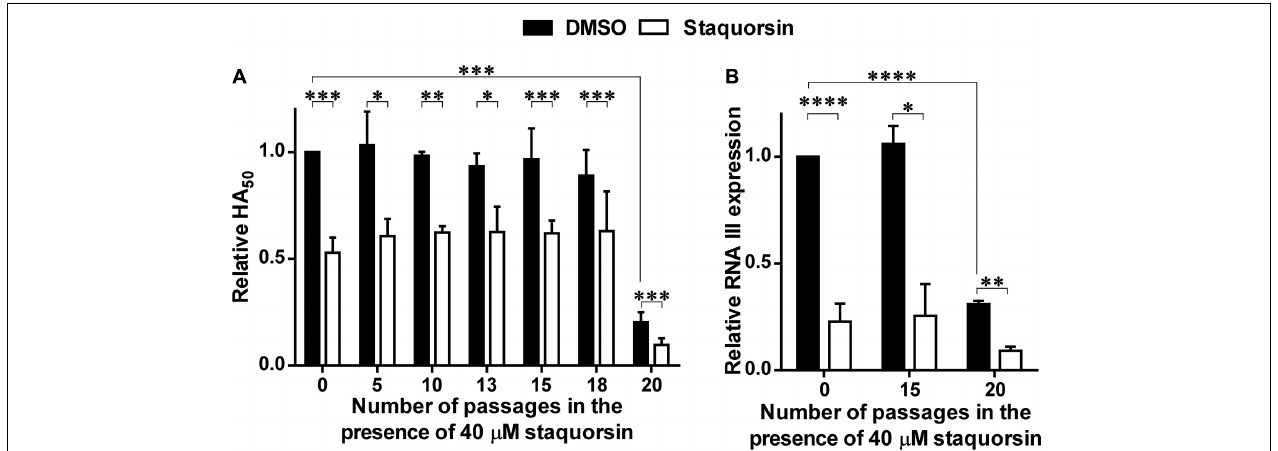
FIGURE 5 | Staquorsin does not lose activity against S. aureus following repeated exposure. S. aureus cells were passed several times in the presence of 40 µ M staquorsin then its effect on the HA 50 of the culture supernatants (A) and the level of the RNA III (B) were assayed. In both charts, the data is presented relative to the results of the S. aureus cells which were not exposed to staquorsin (the first black column). The data presented is the average of three independent experiments and the error bars are the standard deviation. Statistical analyses were performed by applying an unpaired t -test for each pair representing the readings after the indicated number of passages that the cells were exposed to. The “ ∗ ” indicates a p- value ≤ 0.05, “ ∗∗ ” p- value ≤ 0.01, “ ∗∗∗ ” p- value ≤ 0.001, and “ ∗∗∗∗ ” p- value ≤ 0.0001.